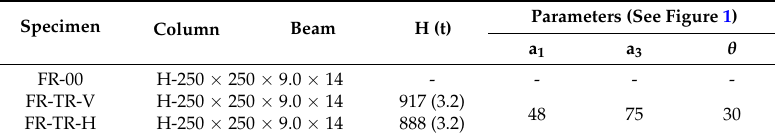
Figure 1. Shape parameter of a trapezoidal-corrugated steel plate.